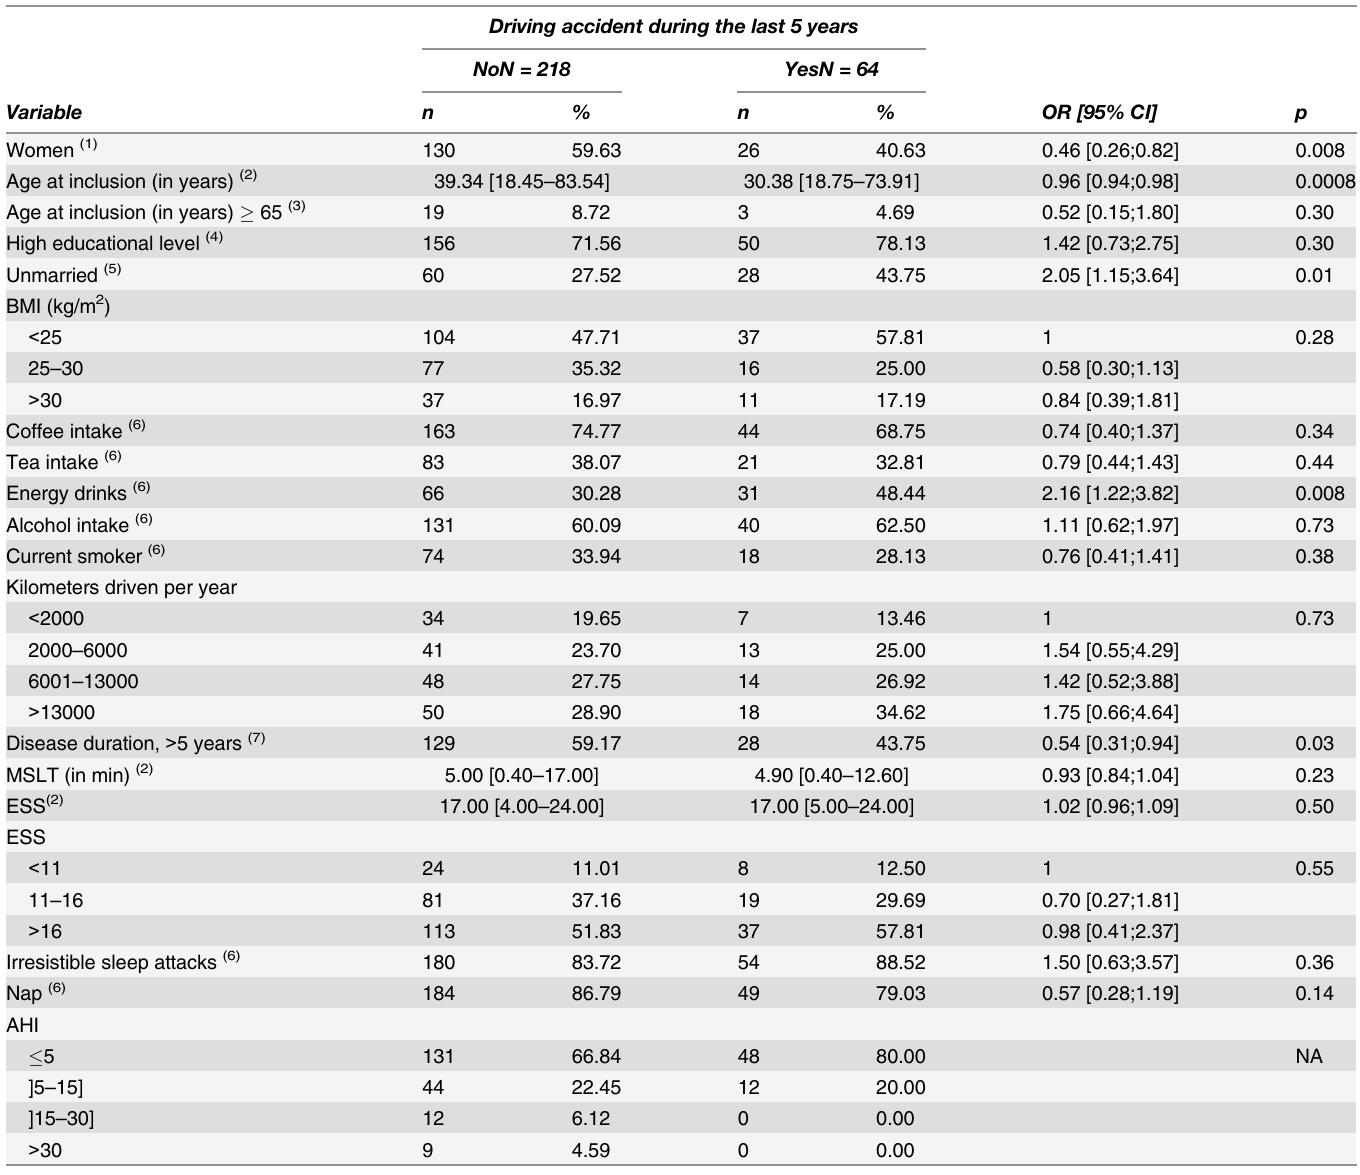
Table 4. Socio-demographic, health behavior, health status and sleep factors according to driving accident during the last 5 years in patients with central disorders of hypersomnolence. Driving accident during the last 5